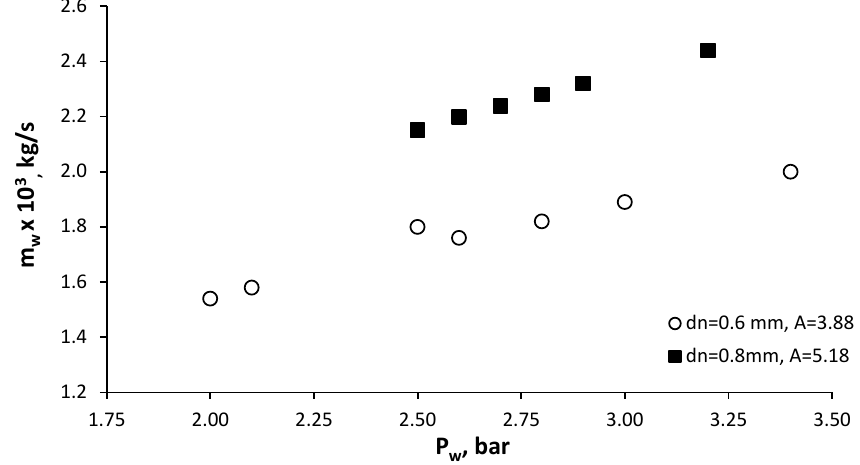
Figure 10. Water flow rate characteristic of the mechanical atomizer.